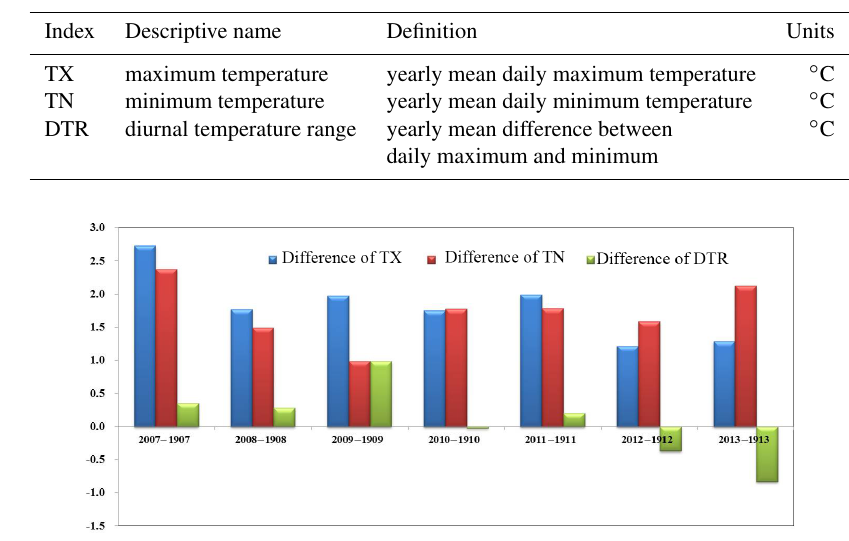
Figure 9. Differences in TX, TN and DTR between the period 1907–1913 and the period of 2007–2013 ( ◦